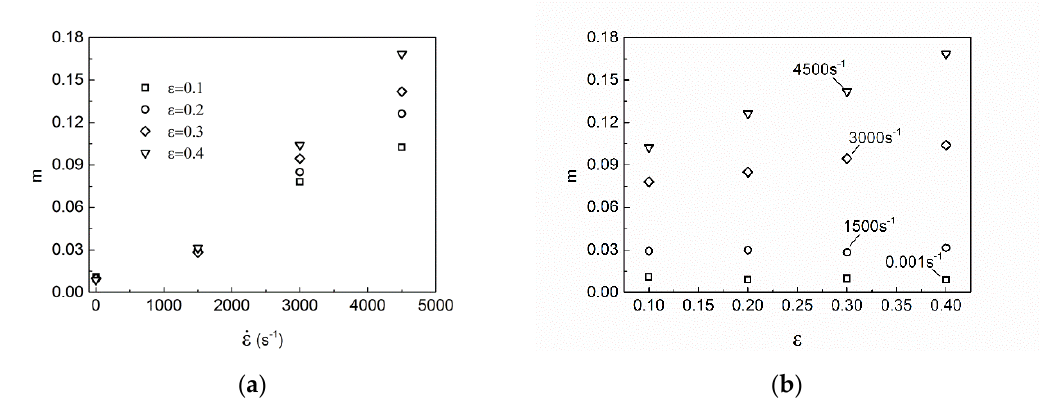
Figure 9. The relationship of ln𝜀̇–ln𝜎 .